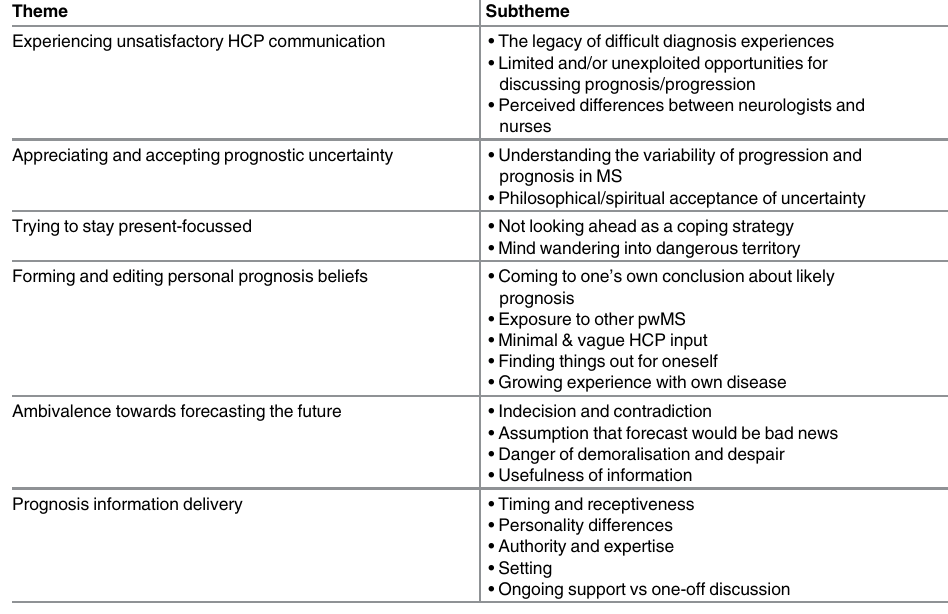
Table 2. Themes and